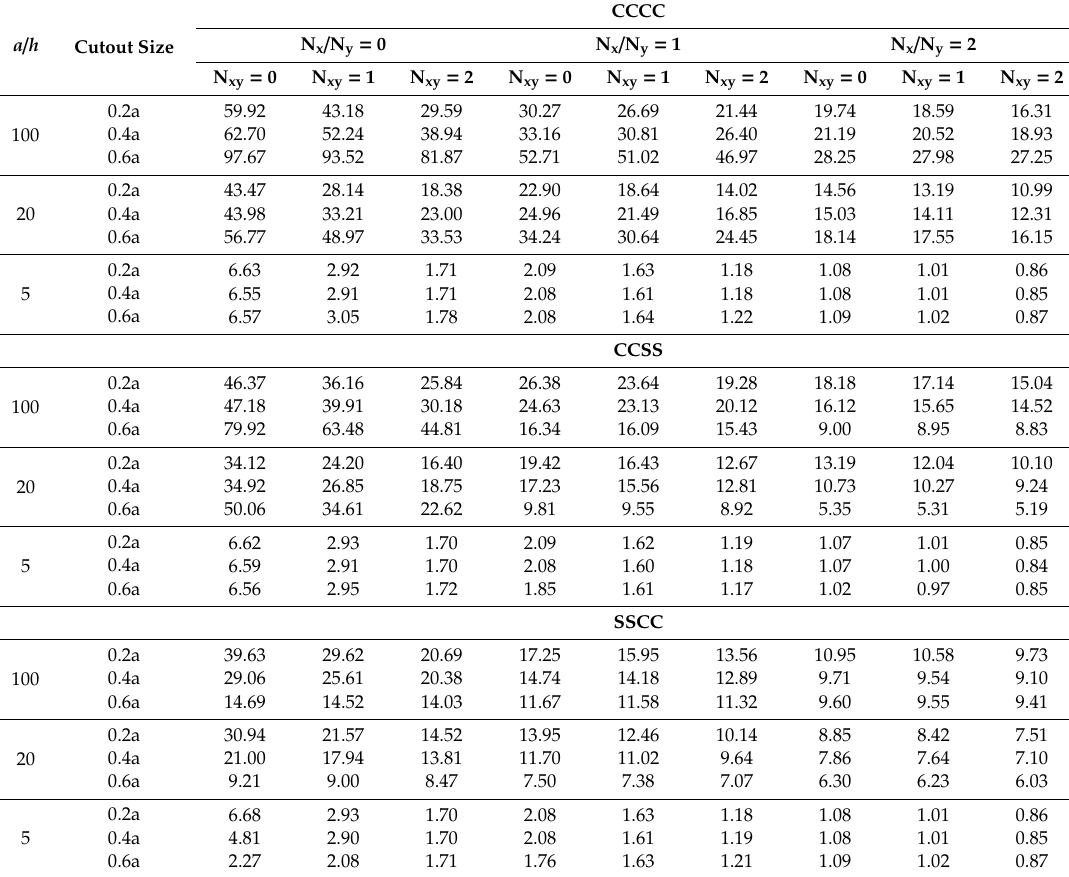
Table 10. Non-dimensional buckling load λ = ( λ b 2 /E 2 h 3 ) for a bi-axial buckling of a composite plate having lamination scheme B and central square